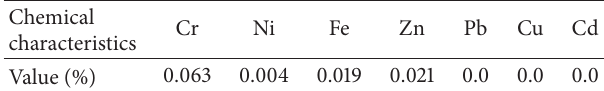
Table 3: Chemical composition of fine steel slag